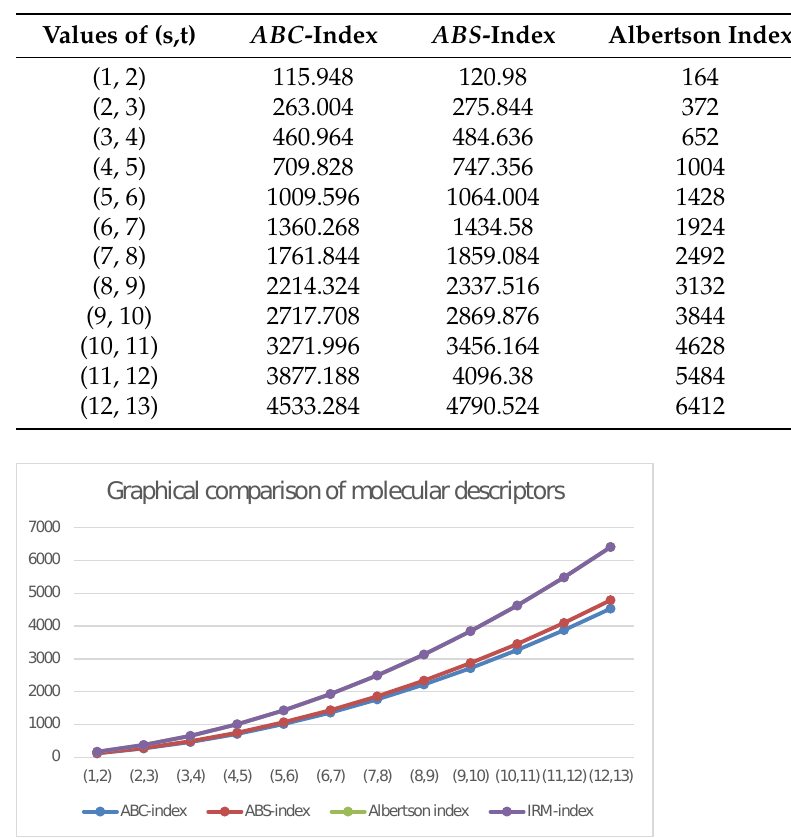
Table 3. Numerical comparison of molecular descriptors.